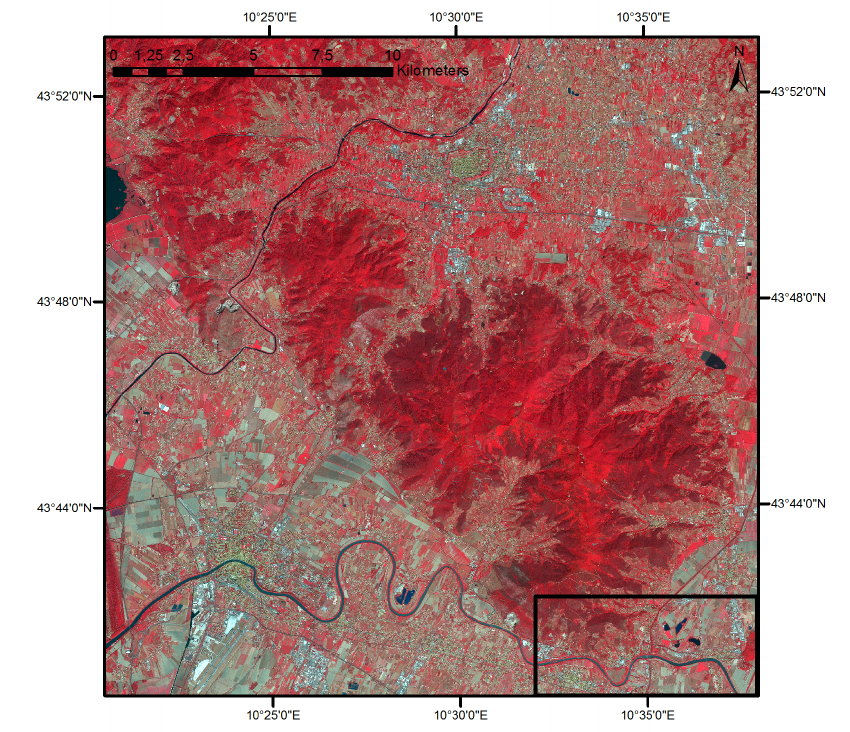
Figure 2. The Spot 5 input image employed in the example, in an RGB “false-color” composite representation (the marked zone from the bottom right corresponds to the area presented in Figure